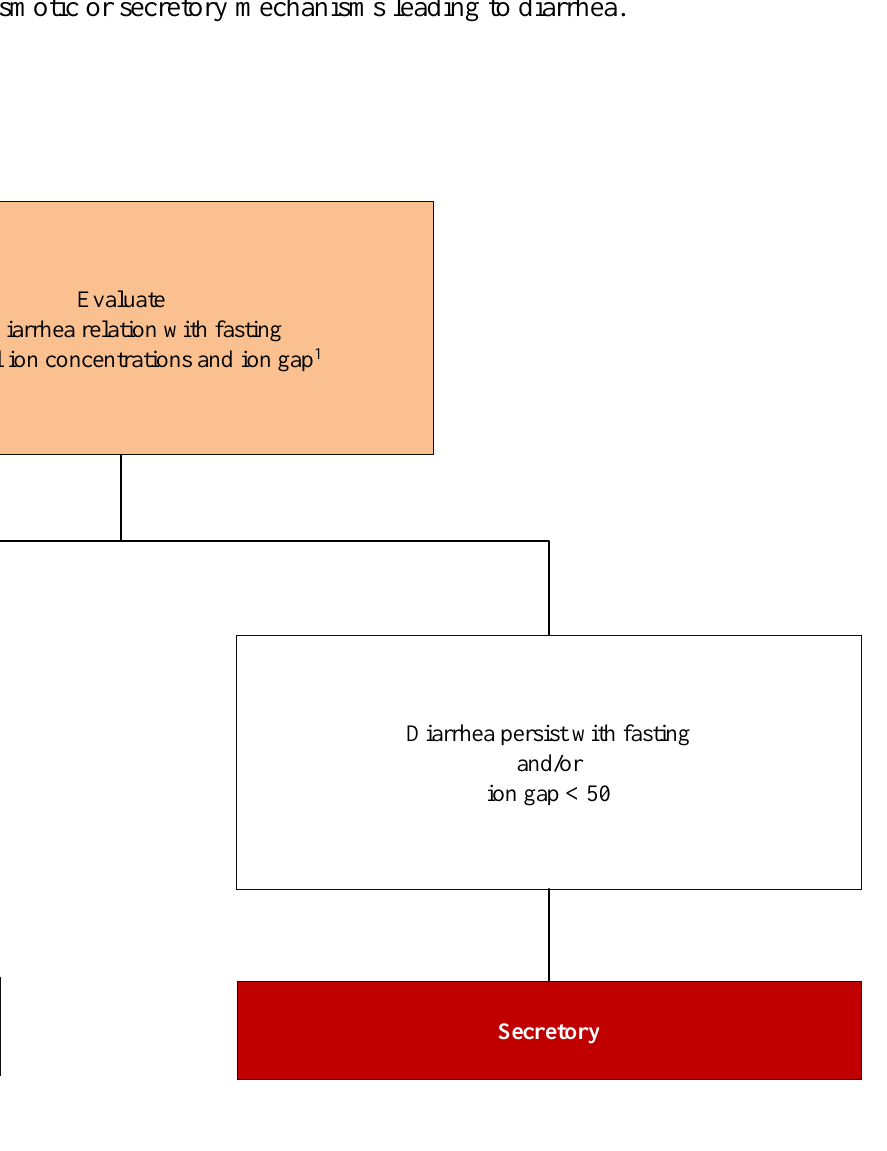
Figure 1. Identification of pathogenetic osmotic or secretory mechanisms leading to diarrhea.